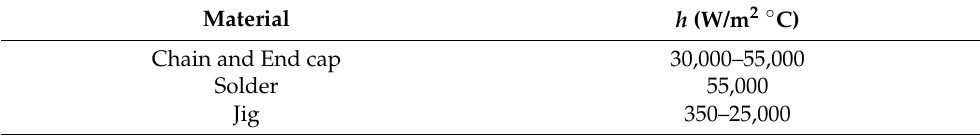
Table 2. The film convection coefficient (data from experiment